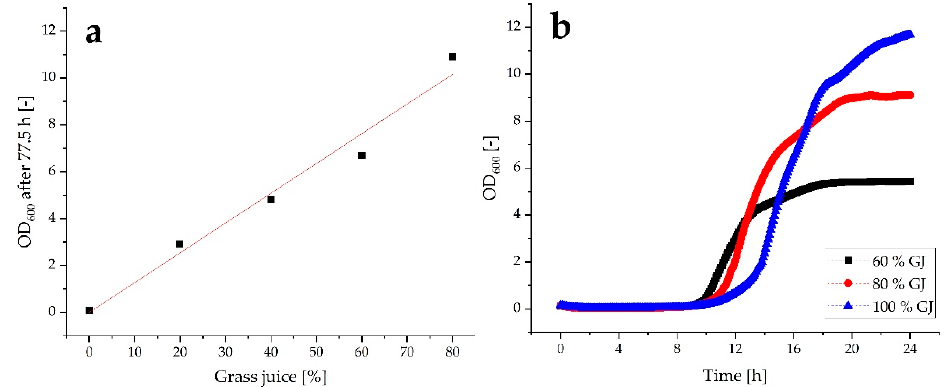
Figure 1. ( a ) Final optical density of C. necator pKR-hum culture after 77.5 h with 0%, 20%, 40%, 60%, and 80% of raw grass juice from the juice extractor diluted in MMasy (linear fit with R 2 = 0.976; n = 1); ( b ) growth curves of C. necator pKR-hum in 60%, 80%, and 100% raw grass juice (GJ) from the juice extractor diluted in MMasy (recorded with the CGQ; n = 1).